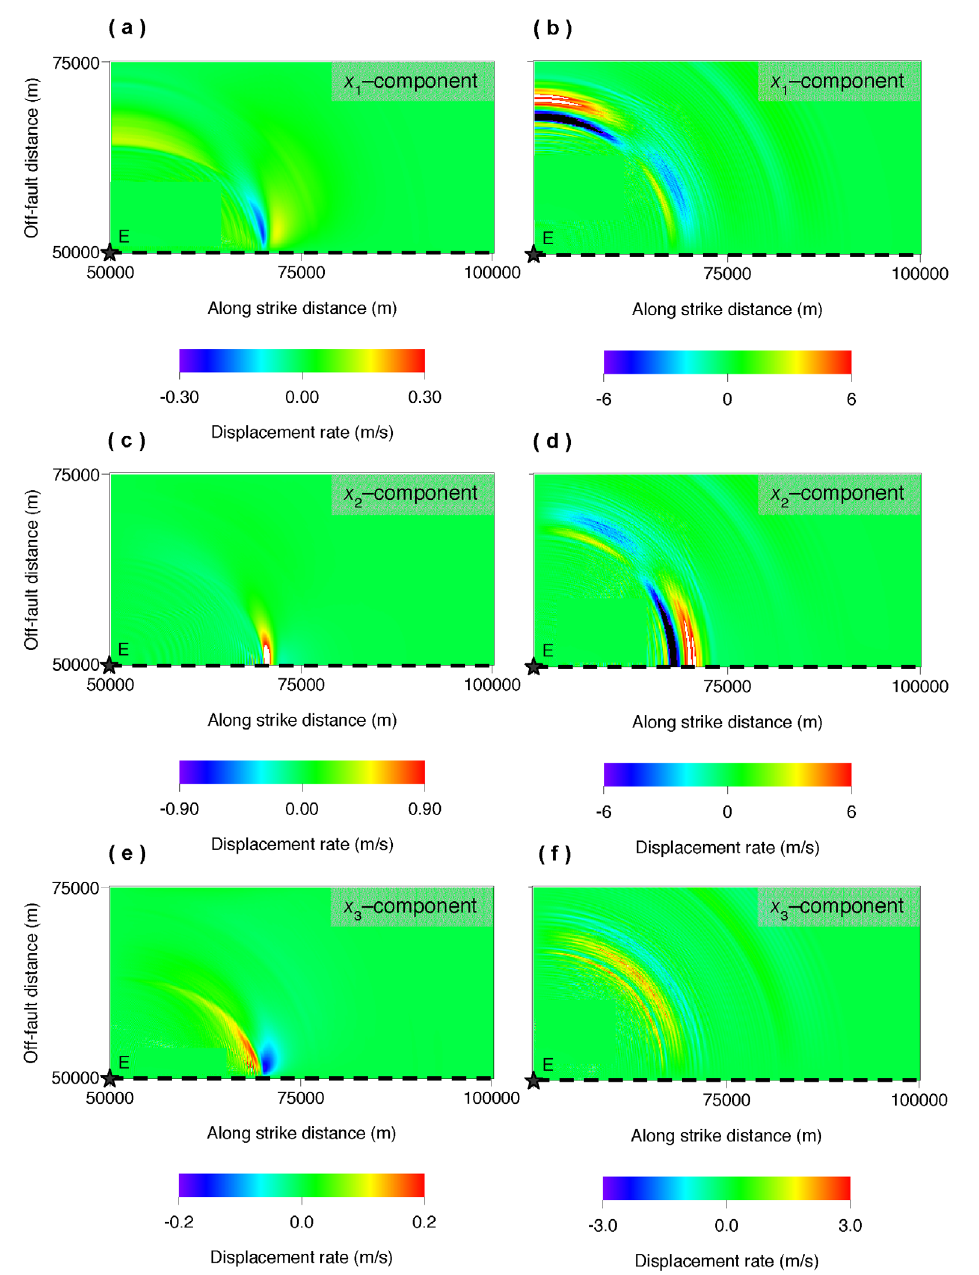
Figure 12. The same as in Figure 11, but now the finite fault model (left panels) pertains to a subshear rupture governed by the Ruina-Dieterich law (the parameters are listed in Table 2). The point-source solution (right panels) has the same seismic moment and total slip (see Section